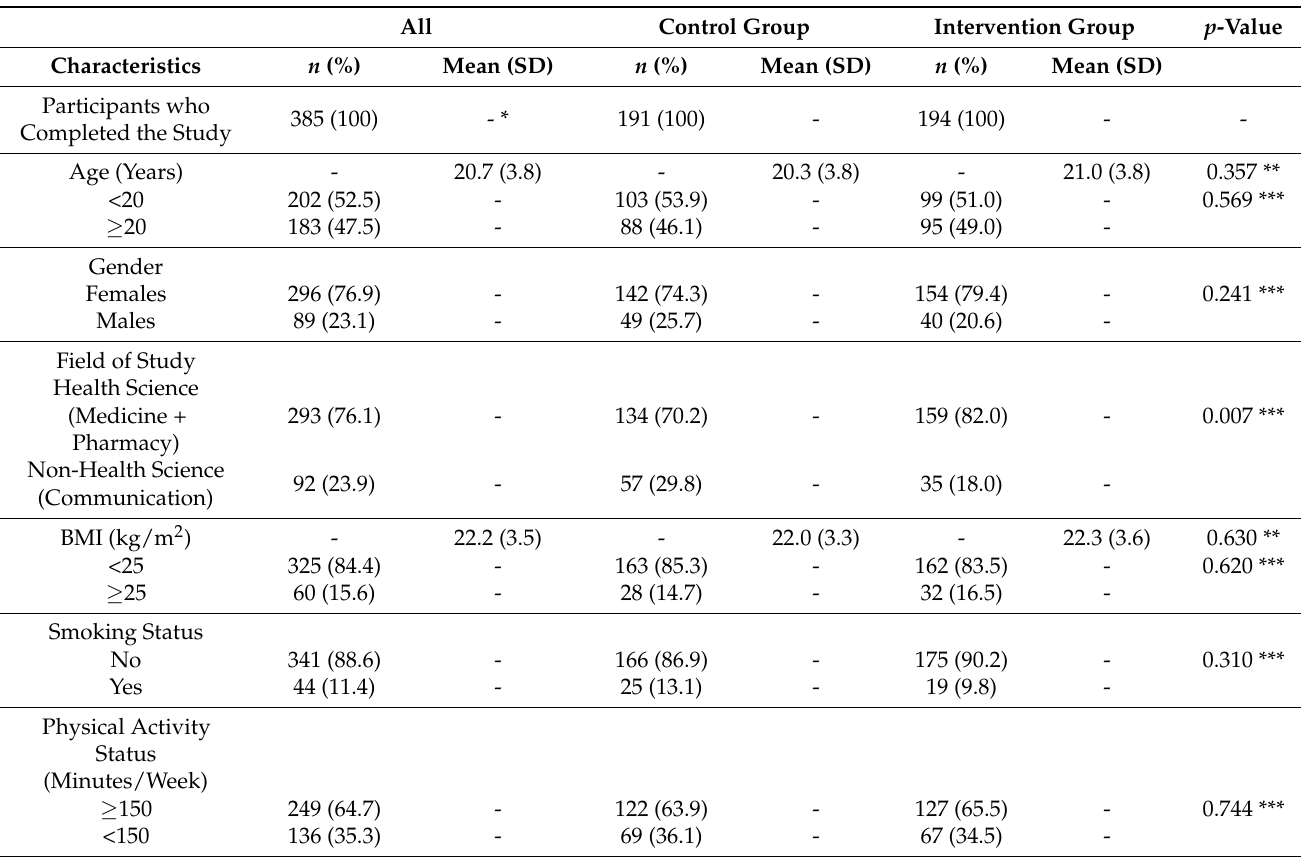
Table 1. Characteristics of the Participants in the